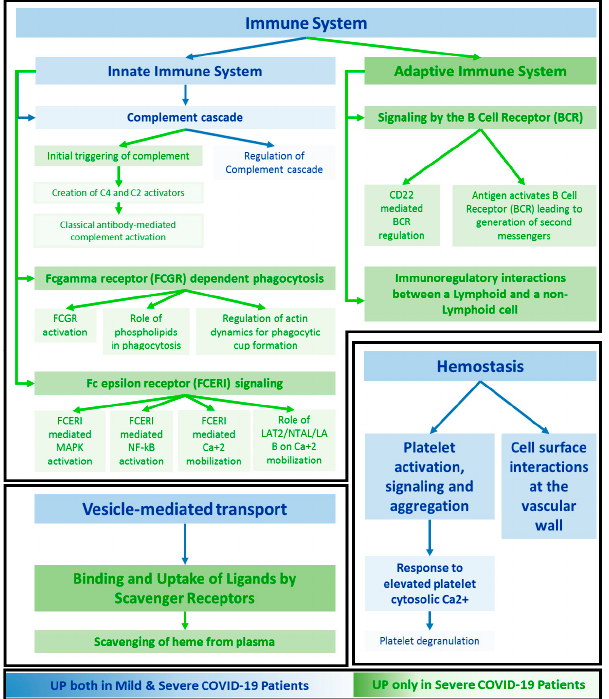
Figure 5. Network of the enriched pathways. Overview of the main significant pathways resulting from enrichment based on the 29 DEPs in Mild and Severe SARS-CoV-2 patients (g:Profiler [17]). The network is illustrated following the hierarchical structure of the Reactome database. Pathways which are enriched only in SEVEREs are in green, while those expressed in both MILDs and SEVEREs are in blue.